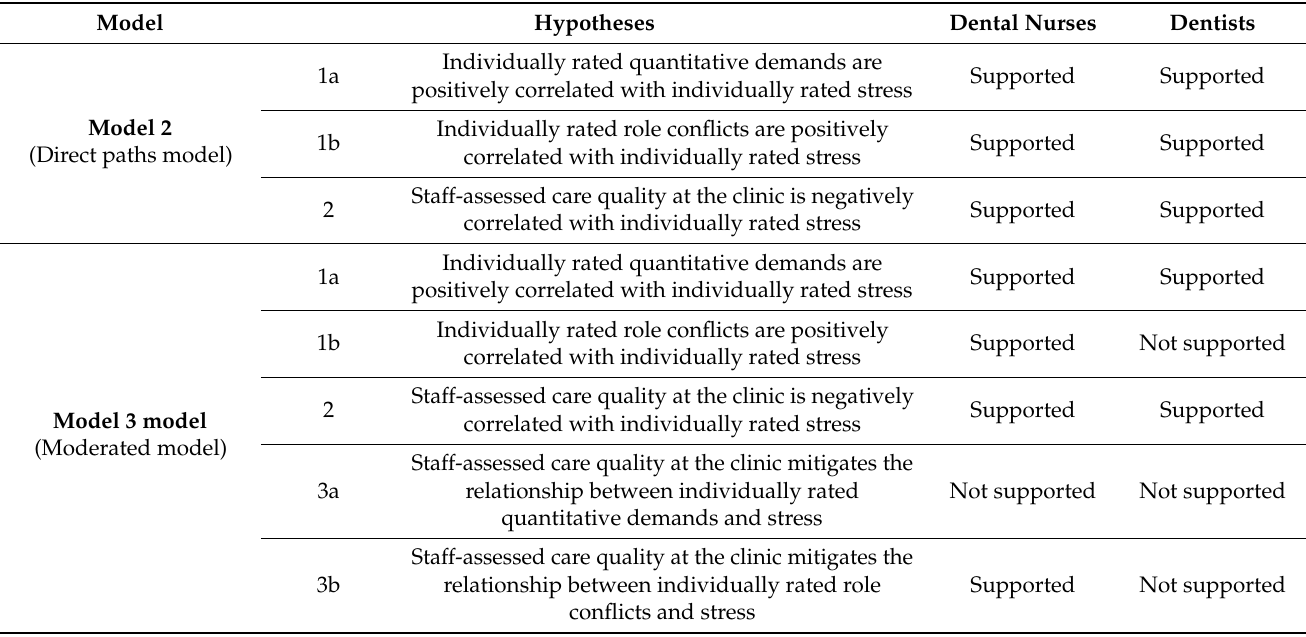
Table 4. Results of the hypotheses for dentists and dental nurses.